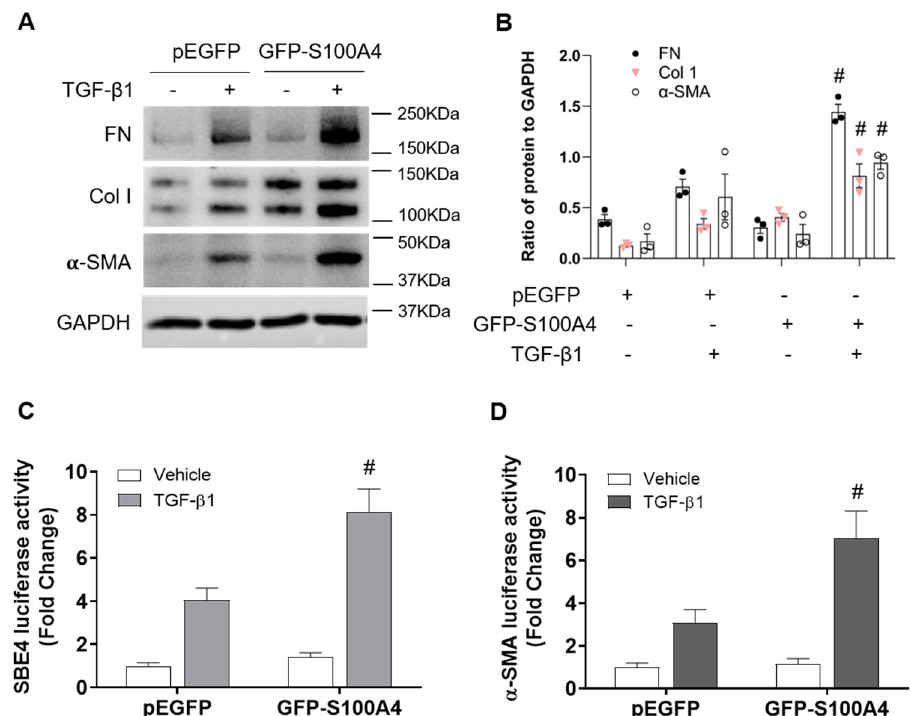
Figure 7. Overexpression of S100A4 stimulates fibroblast activation and TGF- β 1-induced transcrip- tional activity. ( A ) Overexpression of S100A4 (GFP-S100A4) in NRK-49F cells shows enhanced protein levels of fibronectin, collagen 1 and α -SMA treated with TGF- β 1 (2 ng/mL, 24 h). ( B ) Quantitative analysis of fibronectin, collagen 1 and α -SMA protein levels in NRK-49F cells. ( C ) Luciferase assay shows overexpression of S100A4 (GFP-S100A4) enhanced Smad3 promoter activity in NRK-49F cells. ( D ) Luciferase assay shows overexpression of S100A4 (GFP-S100A4) enhanced α -SMA promoter activity in NRK-49F cells. Data are expressed as Mean ± SEM of three independent experiments. # p < 0.05 vs. pEGFP + TGF- β 1.